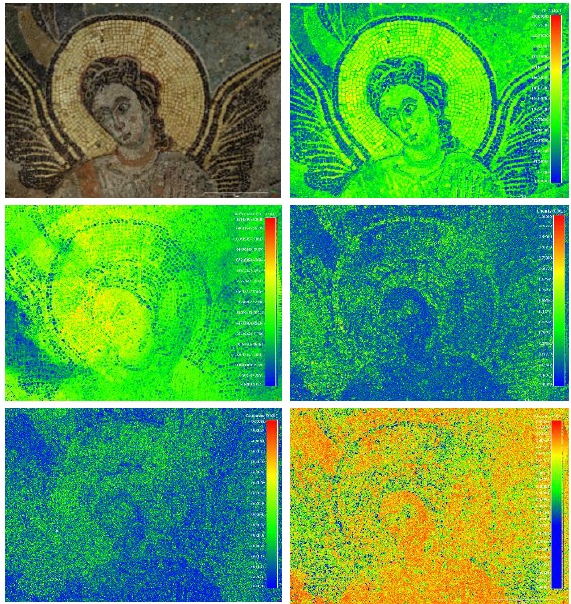
Figure 3. RGB colours, average RGB, the geometric feature and its considered spherical neighbourhood: surface density (r=2 mm), linearity (2 mm), Omnivariance (3 mm), planarity (2mm) (from top to bottom and from left to right) The random forest classifier uses bagging as an ensemble method and a decision tree as an individual model. The set of trees is referred to as a forest. Bagging implies selecting samples from the training subset and trains the trees representing individual classifier. Internal cross-validation technique, using the Gini index, measures the performance of RF and selects the best respective classifiers relying on different learning